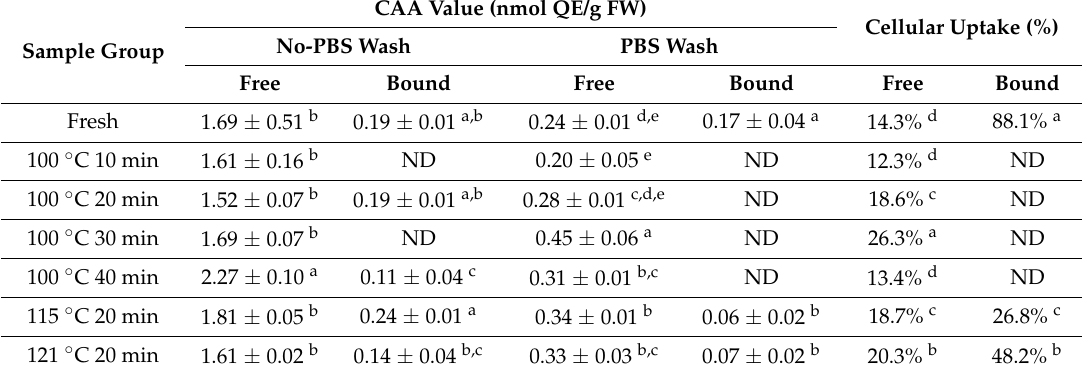
Table 2. Changes of cellular antioxidant activity (CAA) values in chestnut fruits after thermal processing.